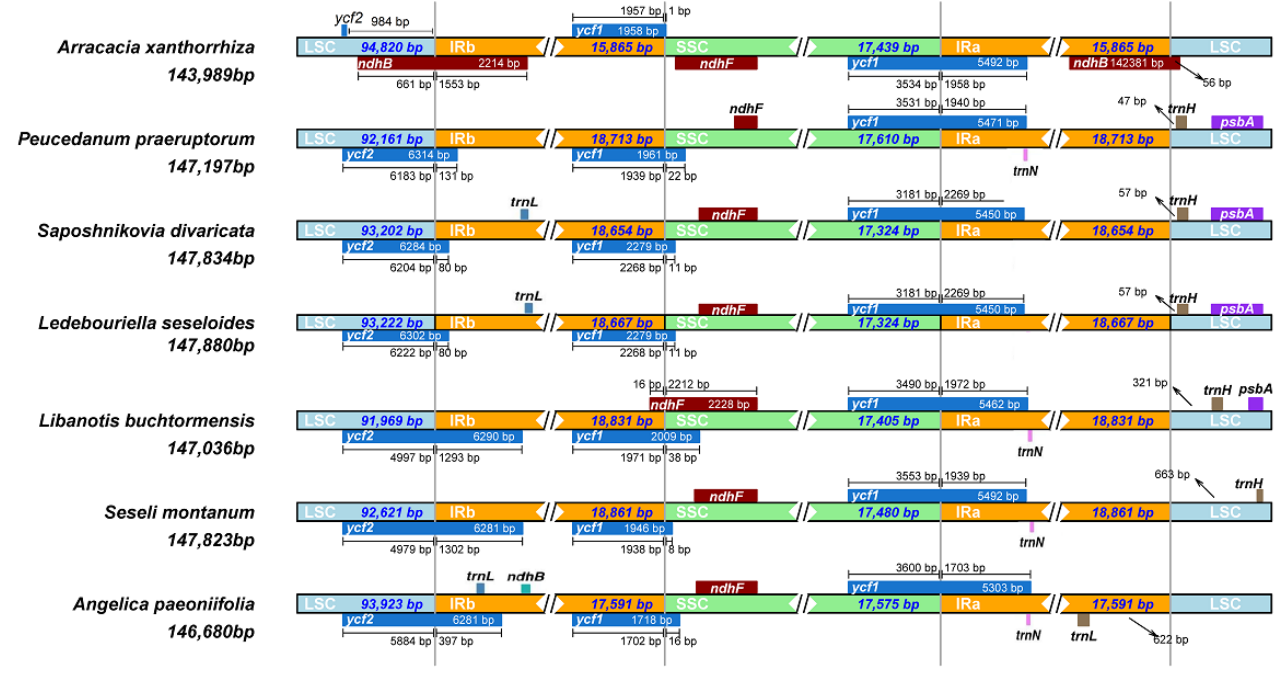
Figure 6. Comparison of the borders of LSC, SSC, and IR regions among seven cp genomes. Table 4. Simple sequence repeats (SSRs) in the wild S. divaricata chloroplast